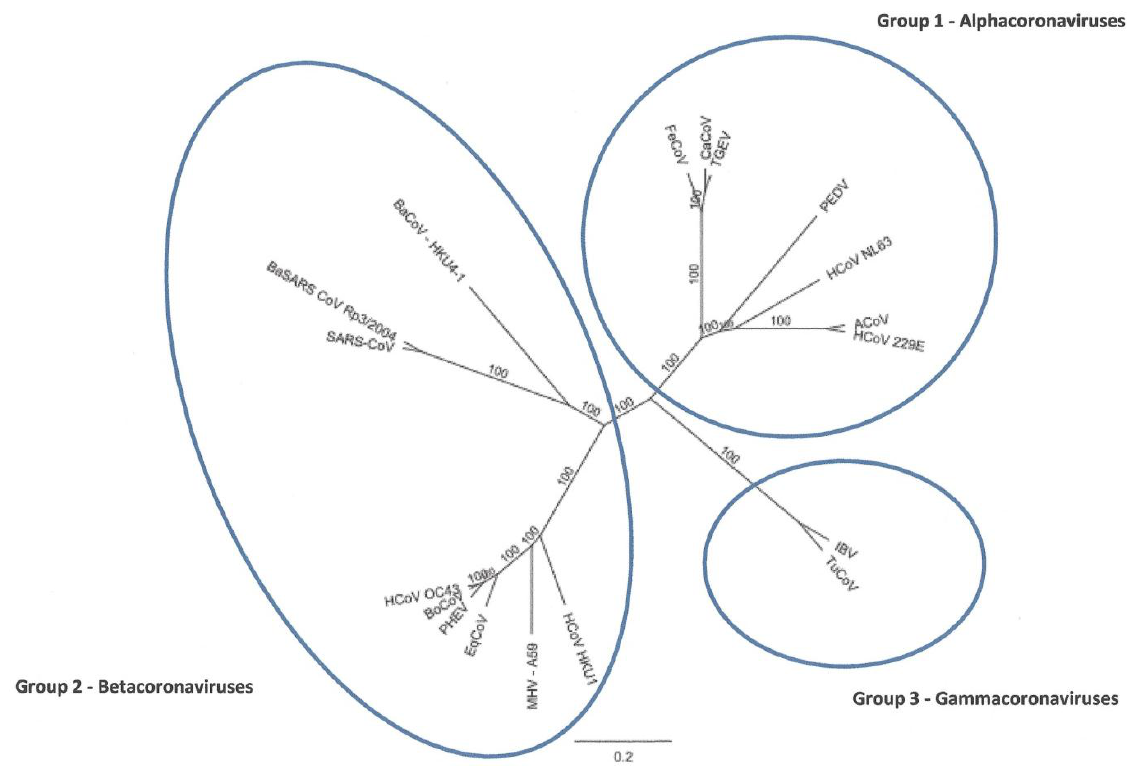
Figure 2. Phylogenetic tree analysis of full-length coronavirus genomes. Alignments were performed using Clustal W and the tree was created using a Neighbor Joining method with no out group (Geneious Pro 5.0.3).